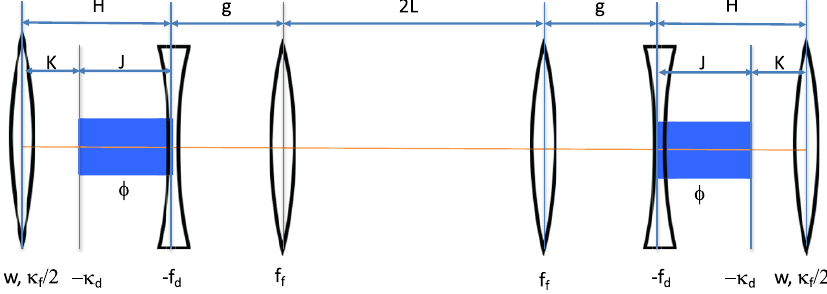
FIG. 2. A periodic double-bend achromat cell with dipole, quadrupole, and sextupole magnets.